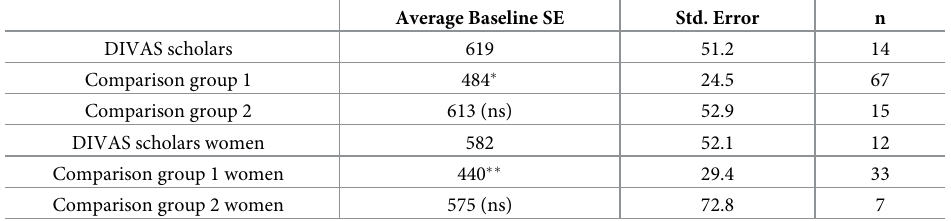
Table 3. Baseline SE of DIVAS scholars compared to other